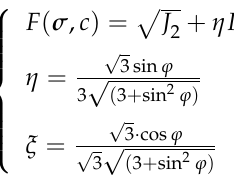
Figure 2. UMAT flowchart of nonlinear generalized Nishihara rheological analysis. Drucker–Prager yield criterion is adopted in this paper, denoted by Equation